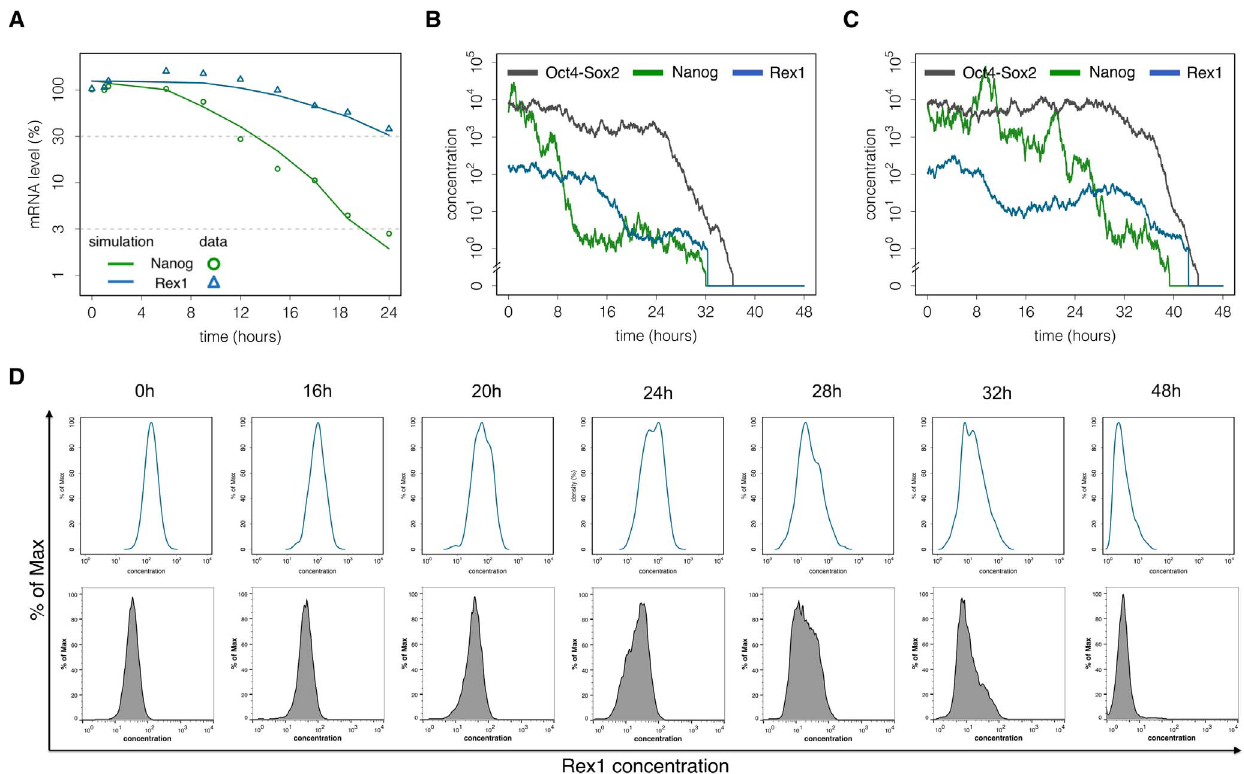
Figure 6. The differentiation process of mESCs. (A) Experimental and simulated TF kinetics. mRNA levels of Nanog (green circles) and Rex1 (blue triangles) are measured after 2i withdrawal and used to adapt the velocity of the differentiation process in terms of the proposed network model. Solid lines depict the respective simulation results of average Nanog and Rex1 levels. (B) – (C) Single cell trajectories. The Nanog level (green) initially switches from the NH into the NL state. Rex1 expression levels gradually decrease (blue). The Oct4-Sox2 level (black) is suddenly downregulated if the intracellular activity Y in becomes sufficiently strong. (D) Flow cytometry measurements of Rex1GFPd2 mESCs show intercellular differences in the differentiation dynamics of Rex1 (lower panel). The respective model results are consistent with the experimental findings (upper panel). The parameter set for these simulations is given in Table S2 in File S1.